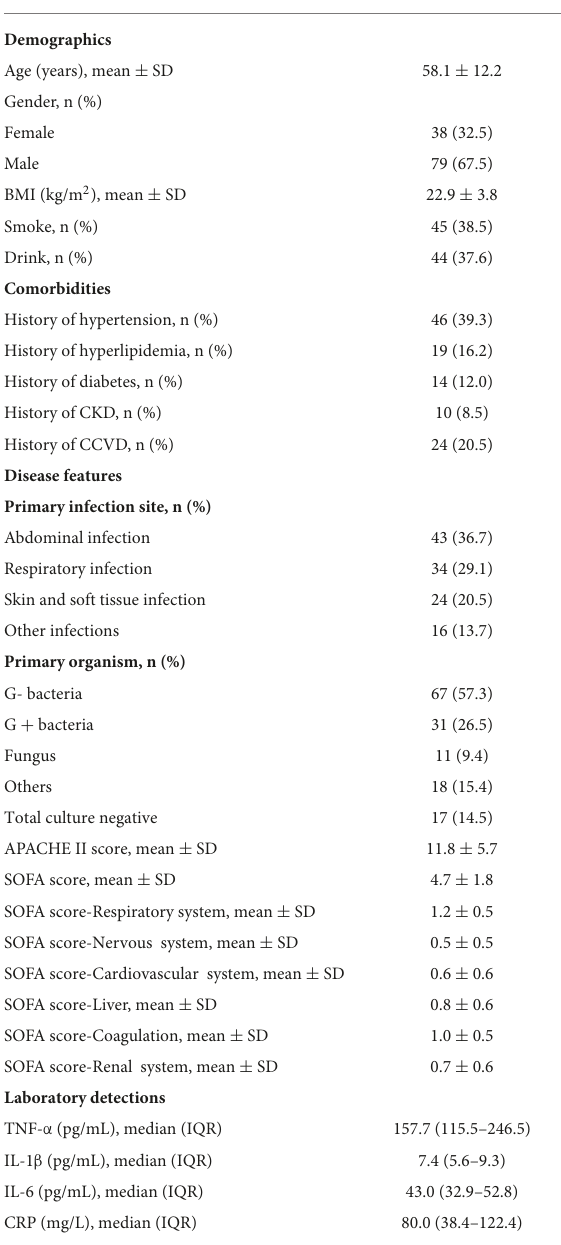
TABLE 1 Clinical data of patients with